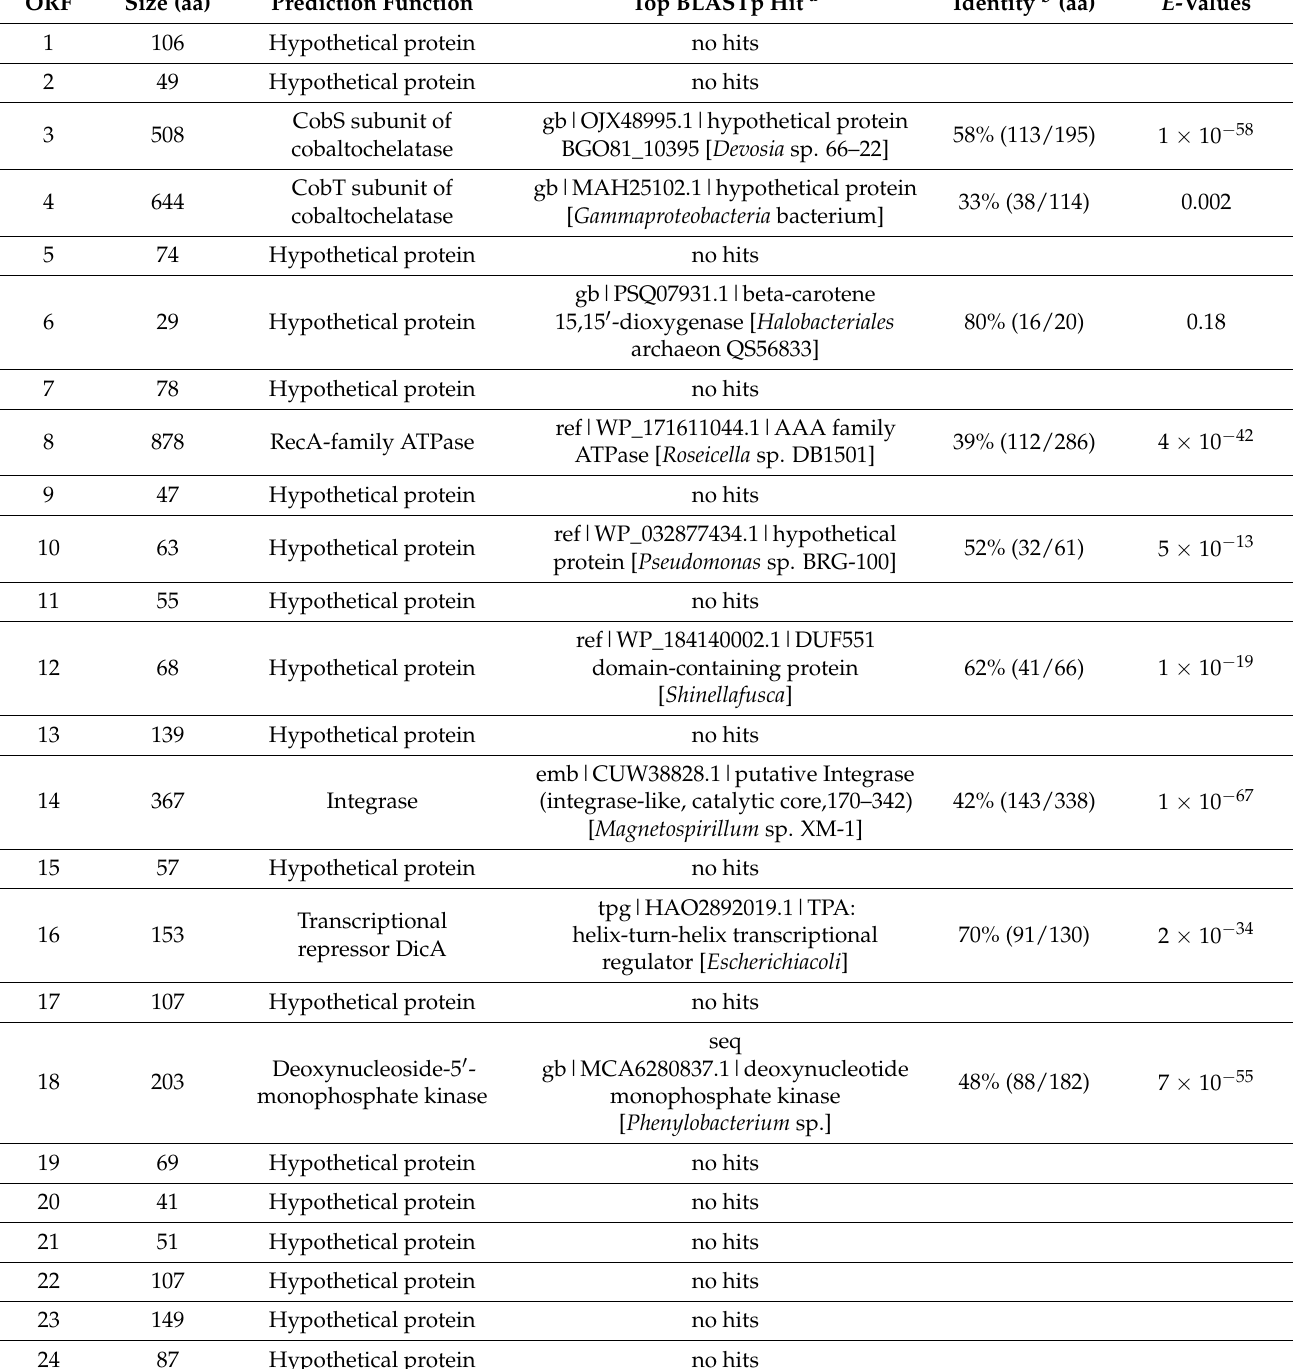
Table 2. Functional prediction and top BLASTp hits of Mae-Yong1326-1